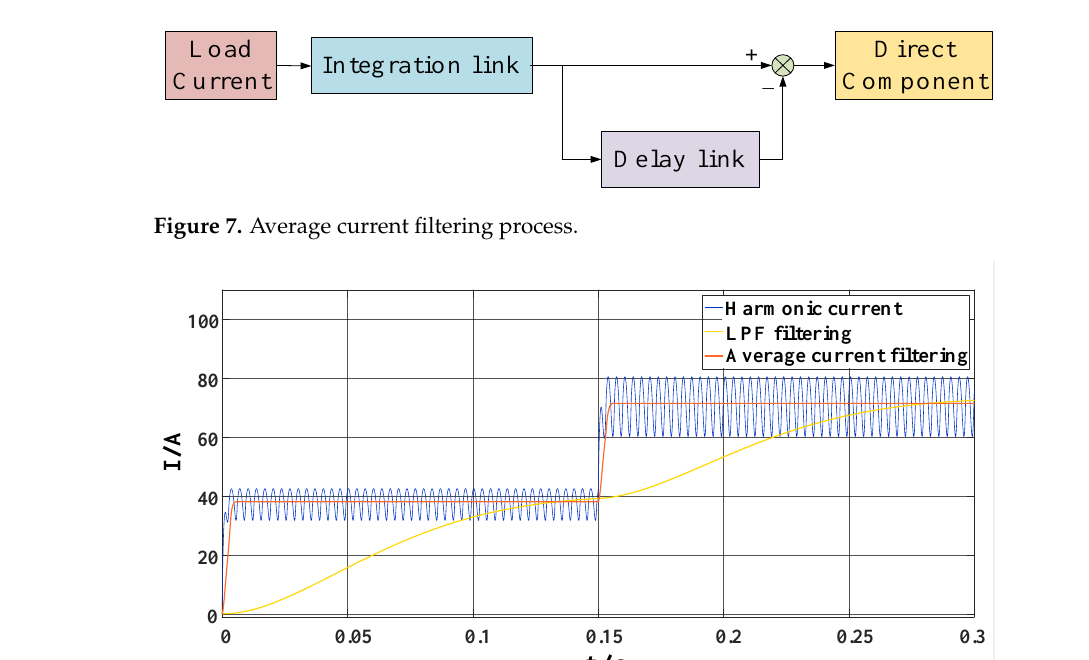
Figure 8. Comparison of LPF filtering and average current filtering schemes.